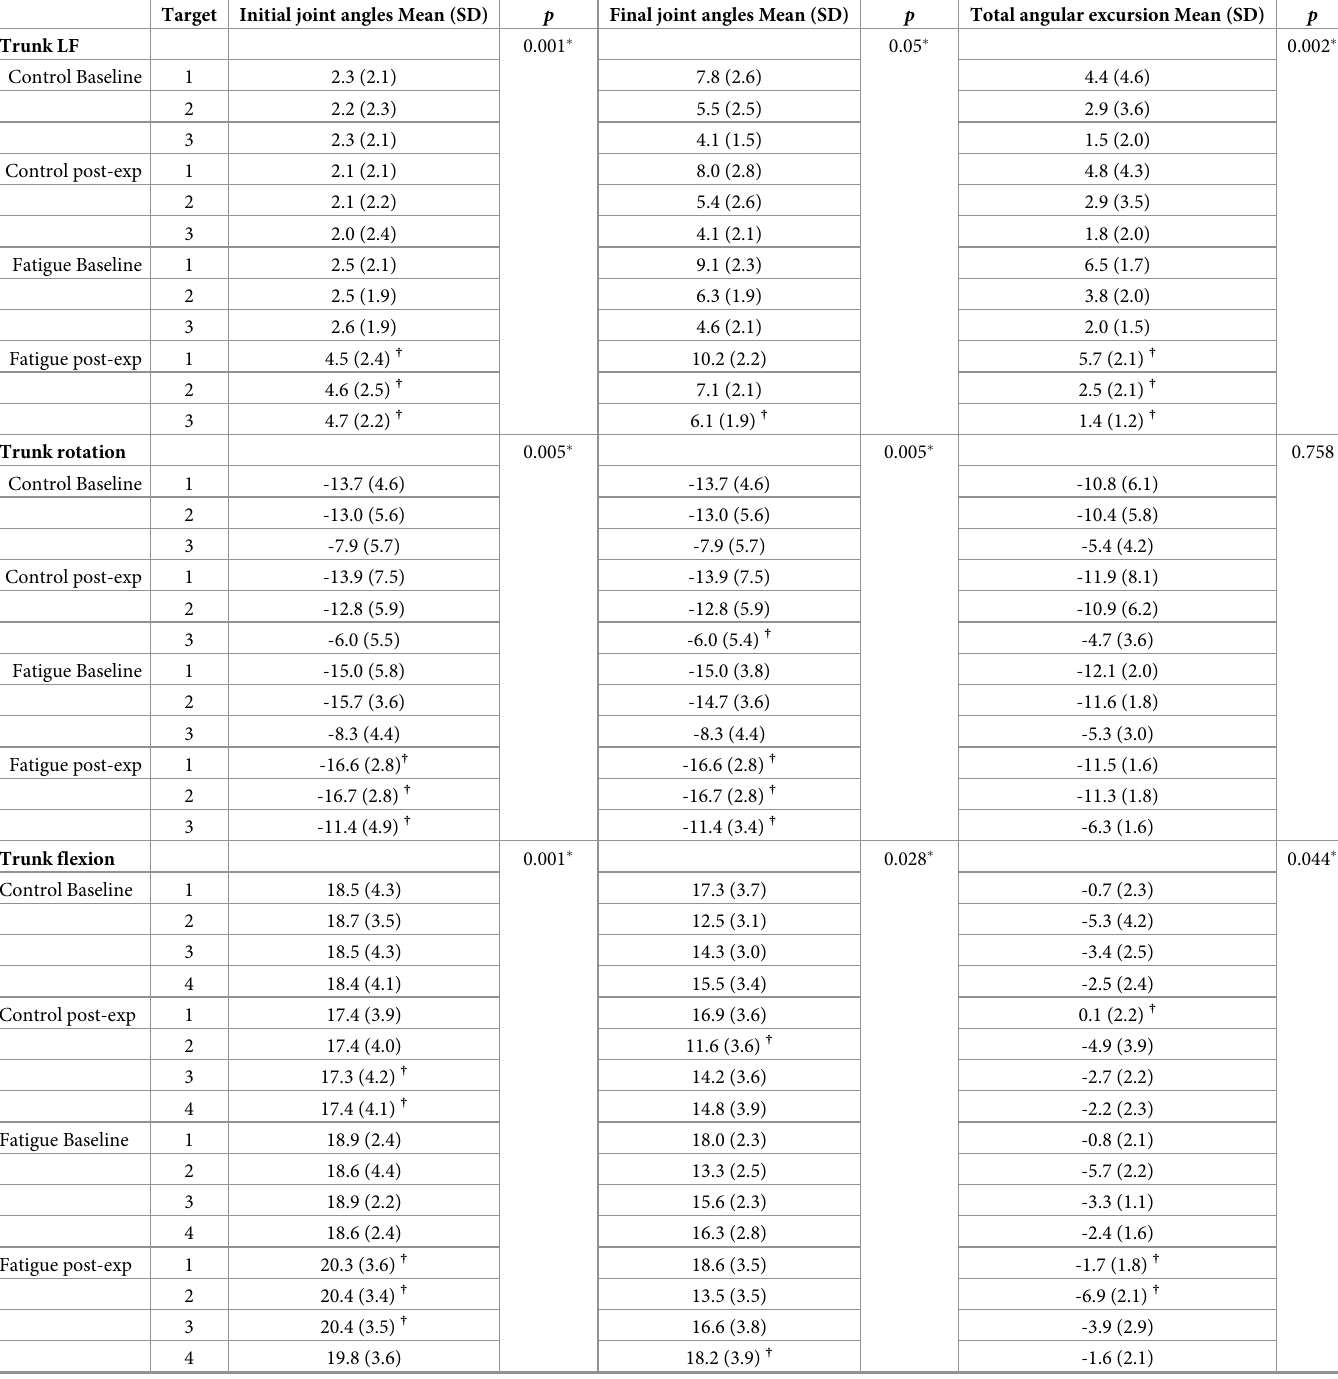
Table 3. Mean total joint excursions during baseline and experimental phase of both